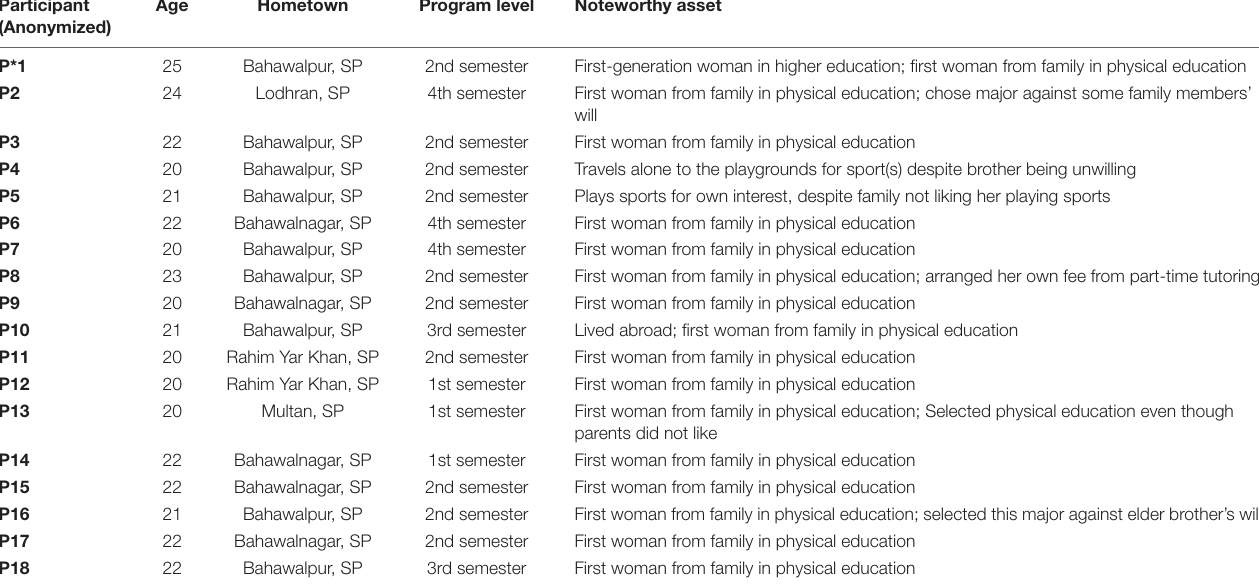
TABLE 1 | Demographic information of the participants. Participant Age Program level Noteworthy (Anonymized)